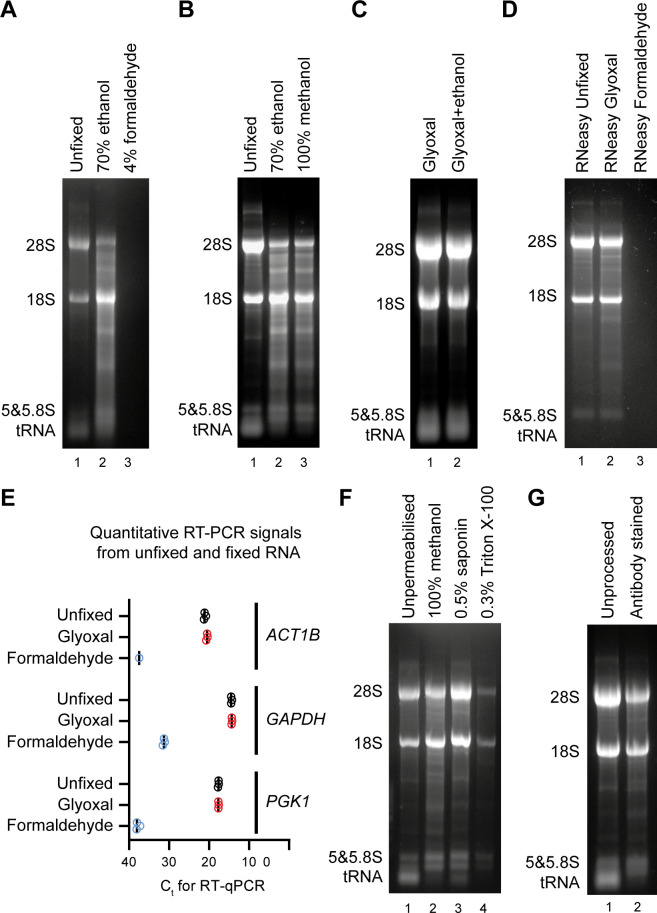
Determination of RNA-compatible fixation and permeabilisation conditions.A: 1x106 COLO205 cells were either unfixed (lane 1), fixed with 70% ethanol on ice for 15 minutes (lane 2) or fixed with 4% formaldehyde on ice for 15 minutes (lane 3). Unfixed cells were dissolved immediately in TRI Reagent, fixed cells were washed once in PBS by centrifugation at 2000 x g for 3 minutes at 4°C before RNA extraction with TRI Reagent. 20% of RNA obtained was separated on a 1.2% glyoxal gel and imaged by ethidium bromide staining. B: COLO205 cells were either unfixed (lane 1), fixed with 70% ethanol on ice for 15 minutes (lane 2) or fixed with 100% methanol on ice for 15 minutes (lane 3). Unfixed cells were dissolved immediately in TRI Reagent, fixed cells were washed once in PBS by centrifugation at 2000 x g for 3 minutes at 4°C before RNA extraction with TRI Reagent. RNA was analysed as in A. C: COLO205 cells were fixed with glyoxal fixation mix (pH4) either without or with 20% ethanol and incubated on ice for 15 minutes and washed once in PBS by centrifugation at 2000 x g for 3 minutes at 4°C. RNA was extracted and analysed as in A. D: COLO205 cells were either unfixed (lane 1), fixed with glyoxal fixation mix (pH4) with 20% ethanol (lane 2) or with 4% formaldehyde on ice for 15 minutes (lane 3). Cells were washed once in PBS by centrifugation at 2000 x g for 3 minutes at 4°C and incubated on ice for 1 hour in 100 μl PBS followed by centrifugation at 2000 x g for 3 minutes at 4°C before RNA extraction with an RNeasy mini kit. E: 100 ng RNA per reaction from D was subjected to one-step combined reverse transcription and quantitative PCR reactions for ACT1B, GAPDH and PGK1. The RNA yield from formaldehyde-fixed RNA cells was <<100ng and therefore control and formaldehyde-fixed reactions were performed on cell equivalents of extracted RNA solution. Ct is the cycle number at which the fluorescence exceeded threshold. 3 technical replicates for each RT-qPCR reaction were performed. F: COLO205 cells were either unfixed (lane 1) or fixed with glyoxal fixation mix (pH4) with 20% ethanol on ice for 15 minutes and permeabilised in 100% methanol on ice for 30 minutes (lane 2), or 0.5% saponin on ice for 30 minutes (lane 3) or 0.3% Triton X-100 on ice for 30 minutes (lane 4). RNA was analysed as in A. G: COLO205 cells were either unfixed (lane 1) or fixed with glyoxal fixation mix (pH4) with 20% ethanol on ice for 15 minutes, permeabilised in 100% methanol on ice for 30 minutes followed by incubation in primary antibody for 1 hour on ice and secondary antibody for 30 minutes on ice in dark (lane 2). RNA was analysed as in A.